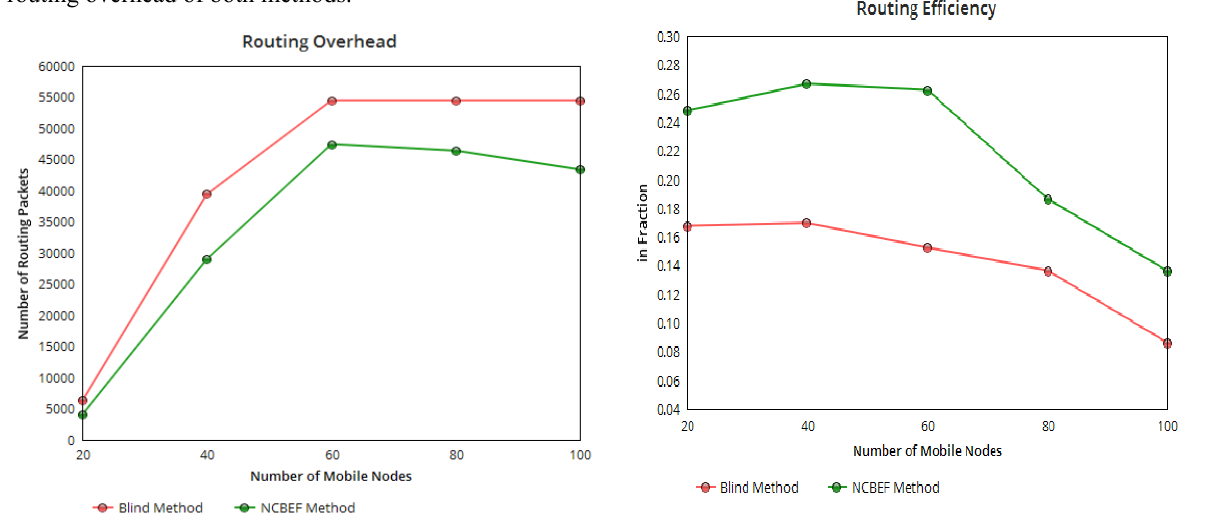
Figure 9. Comparative routing overhead Network Life - NCBEF method results more